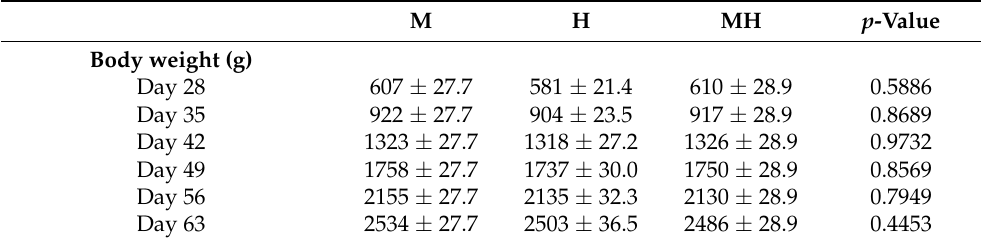
Table 4. Performance traits of animals fed the experimental diets (M, H and MH) during the fattening period (n = 140) (average ± standard